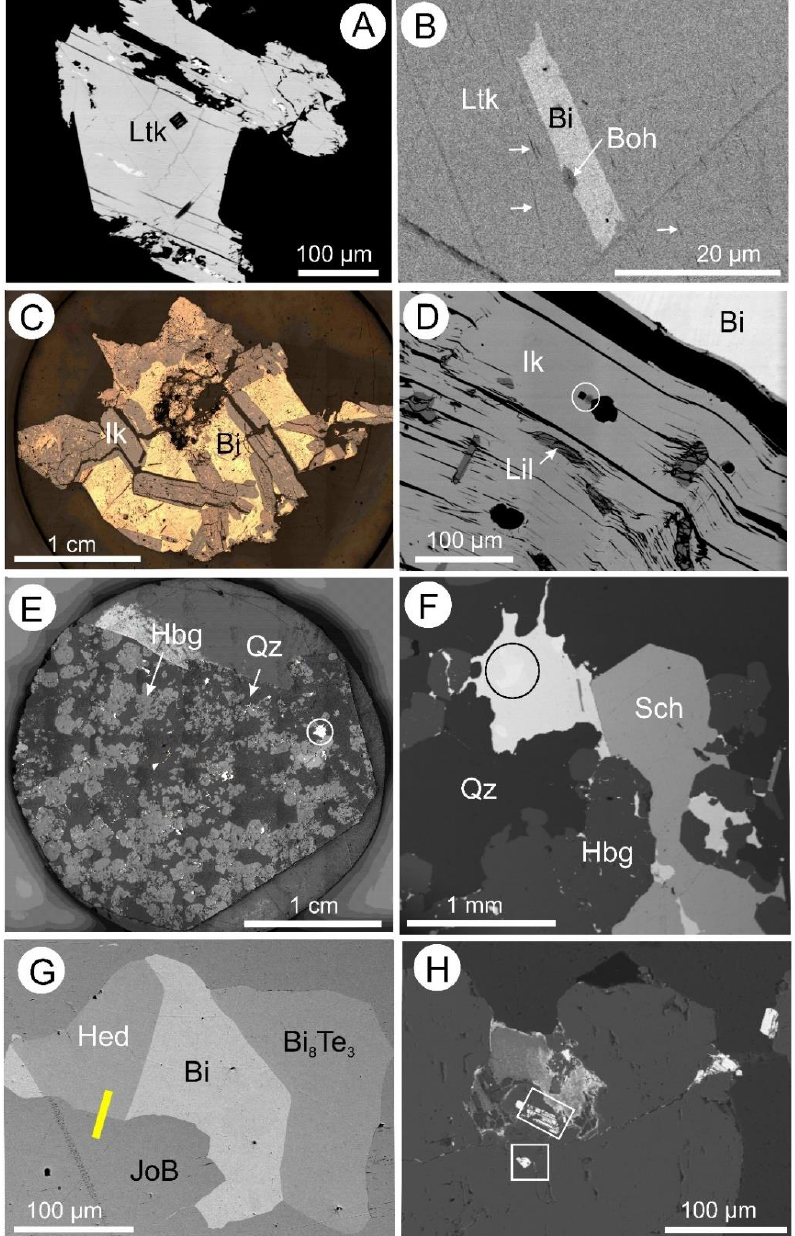
Figure 2. BSE images (except C and E, which are reflected light photomicrographs) showing petro- graphic aspects of studied specimens. ( A ) Platy laitakarite (Ltk) with location of FIB-cut indicated (black diamond-shaped area). ( B ) Detail of area from which the foil was extracted prior to cross- sectioning. This shows typical inclusions of native bismuth (Bi) and minor bohdanowiczite (Boh) within laitakarite. White arrows show sub-micron-scale sets of acicular inclusions identified in the nanoscale study as galena + bohdanowiczite. ( C ) Ikunolite (Iku) as coarse laths within native bismuth. ( D ) Detail showing inclusions of lillianite–gustavite solid solution (Lil) within ikunolite. Location of FIB-cut is indicated by white circle. ( E ) Hedenbergite (Hbg) skarn specimen from Hedley, containing disseminations of Bi-minerals (e.g., marked by white circle). Abundant quartz (Qz) is also present. ( F ) Multi-component Bi-mineral assemblage from the circle marked in ( E ) associated with scheelite (Sch). ( G ) Detail of Bi-mineral assemblage in ( F ) comprising jos é ite-B (JoB), native bismuth, hedleyite (Hed) and unnamed Bi 8 Te 3 . Yellow bar shows location of FIB-cut. ( H ) Small grains of jos é ite-A (marked by white boxes) along trails with retrograde chlorite (replacing